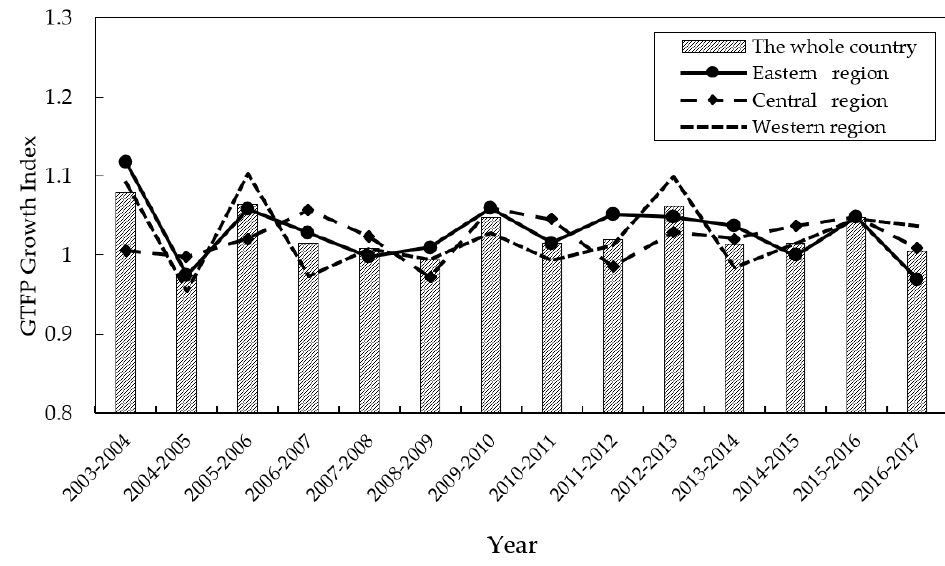
Figure 3. Trends of regional average GTFP growth index in China from 2003 to 2017.